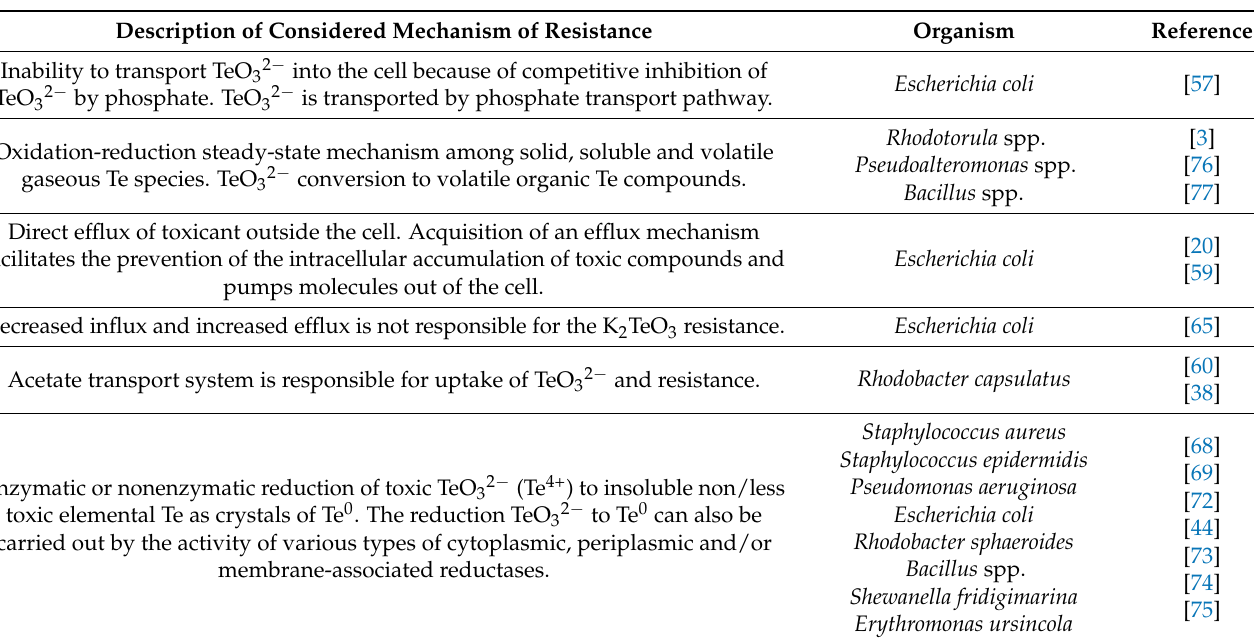
Table 1. Proposed putative tellurite (TeO 32 − ) resistance